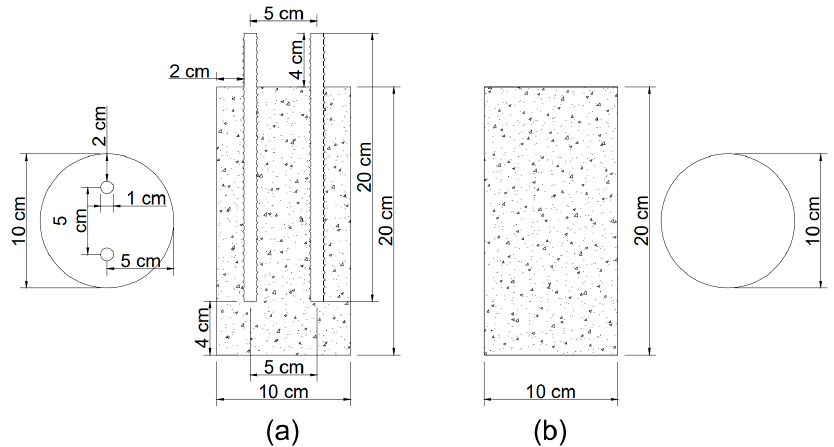
Figure 1. Specimens: ( a ) with steel rods and ( b ) without steel